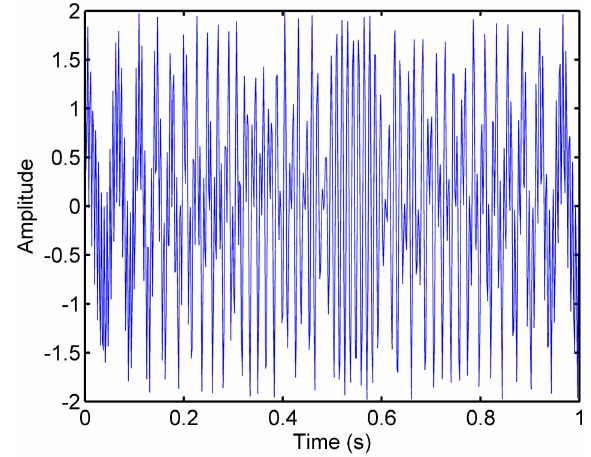
Figure 1. The double linear chirped